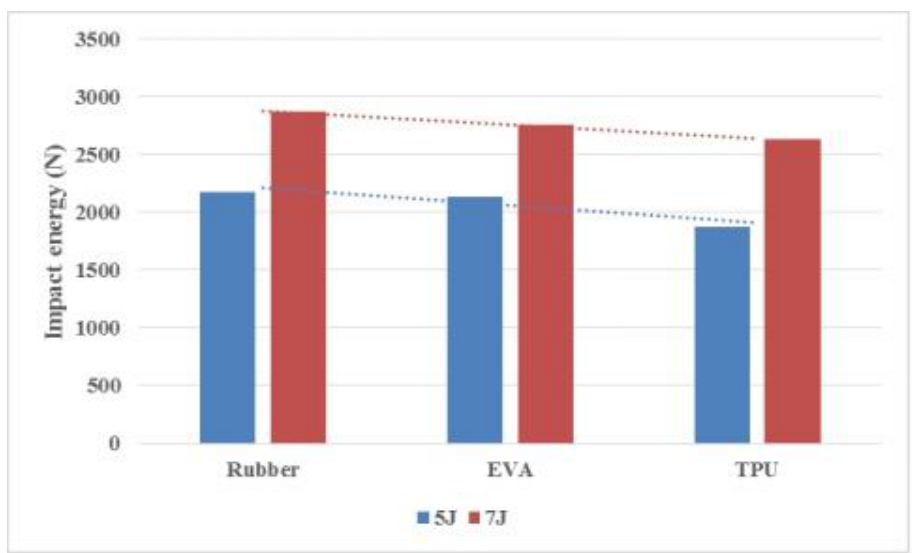
Figure 3: Peak contrast of different impact energy